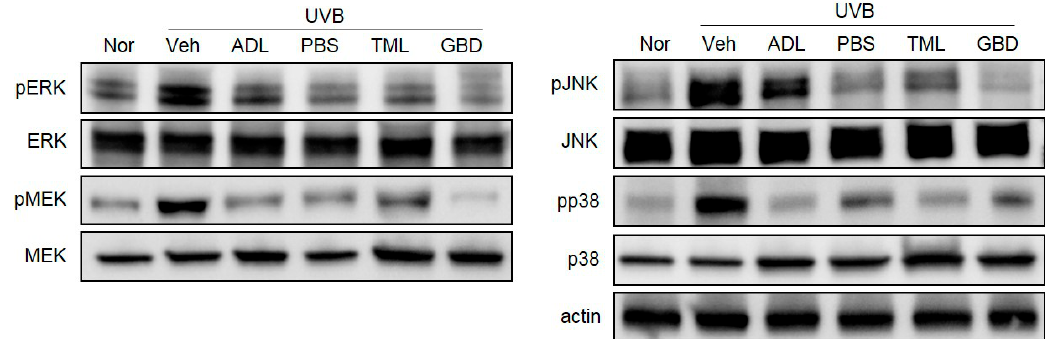
Figure 5. E ff ects of insect extracts on the phosphorylation of mitogen-activated protein kinases (MAPKs) in the UVB-irradiated mouse model. Insect extracts inhibited the phosphorylation of MAPK kinase (MEK), extracellular signal-regulated kinase (ERK), p38, and c-Jun N-terminal kinase (JNK). The prefix p means phosphorylation. Nor, Normal; Veh, Vehicle; ADL, Allomyrina dichotoma larva; PBS, Protaetia brevitarsis seulensis ; TML, Tenebrio molitor Linnaeus; GBD, Gryllus bimaculatus De Geer.